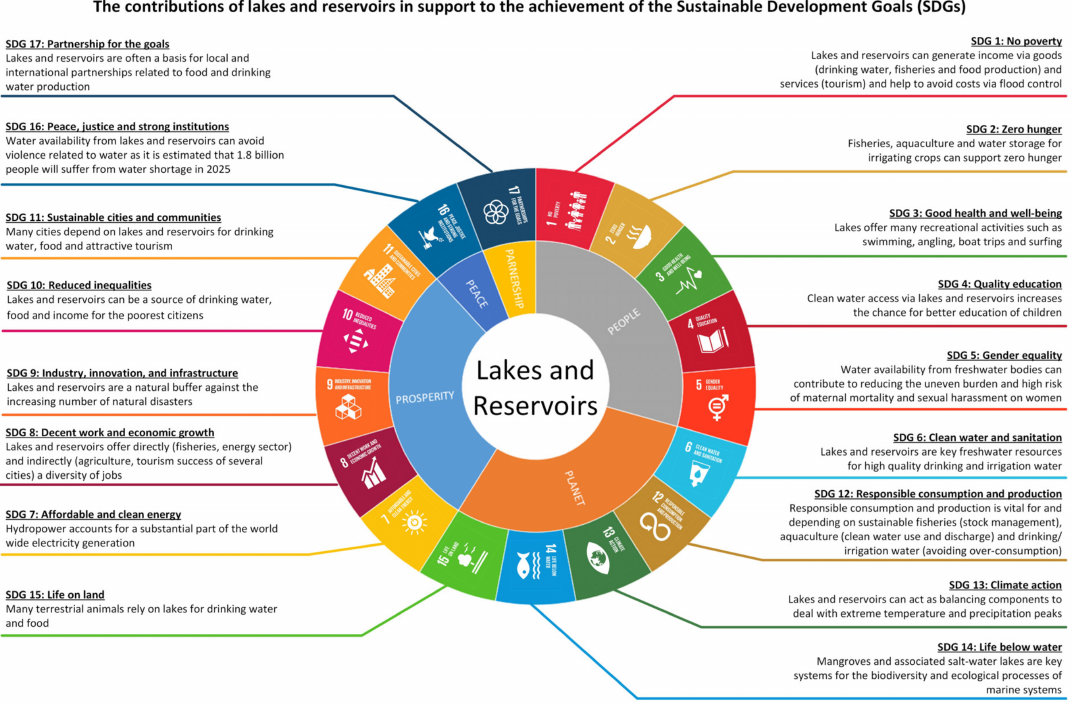
Figure 3. The summary of the contributions of lakes and reservoirs to support the achievement of the Sustainable Development Goals (SDGs).